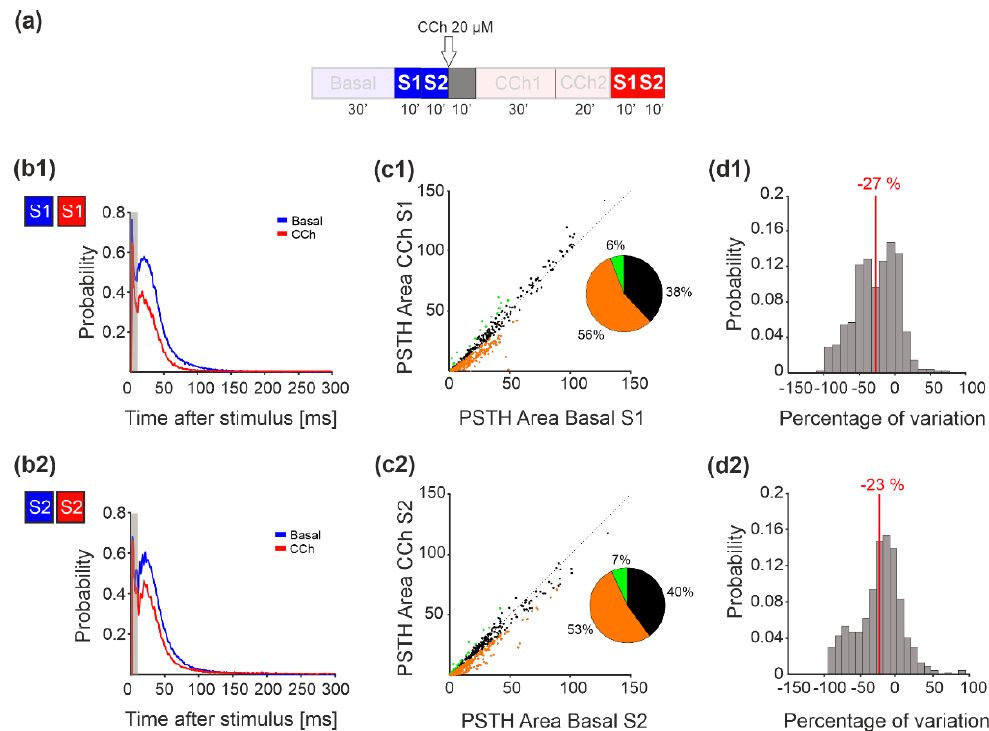
Figure 6. PSTH area analysis. ( a ) Experimental protocol adopted for the experiments. The stimulation phase analyzed here is highlighted. Cortical cultures were stimulated for 10 min at two different sites under basal conditions and after CCh treatment. ( b ) Network PSTH measured in one representative experiment during both stimulation sessions under basal conditions (blue lines) and after CCh treatment (dark red lines). ( c ) The PSTH area of all the experiments for both stimulation sessions showed a higher percentage of channels that decreased relative to the basal level. The variation in each channel was considered significant if it was greater than 20% of the threshold computed by measuring the variation during the stability phases. Orange dots indicate channels that decreased with respect to the basal conditions, green dots indicate channels that increased, and black channels are the ones that did not change. ( d ) The histogram of the percentage of variation for both stimulation sessions showed a mean value centered at − 27 for stimulus 1 and at − 23 for stimulus 2.